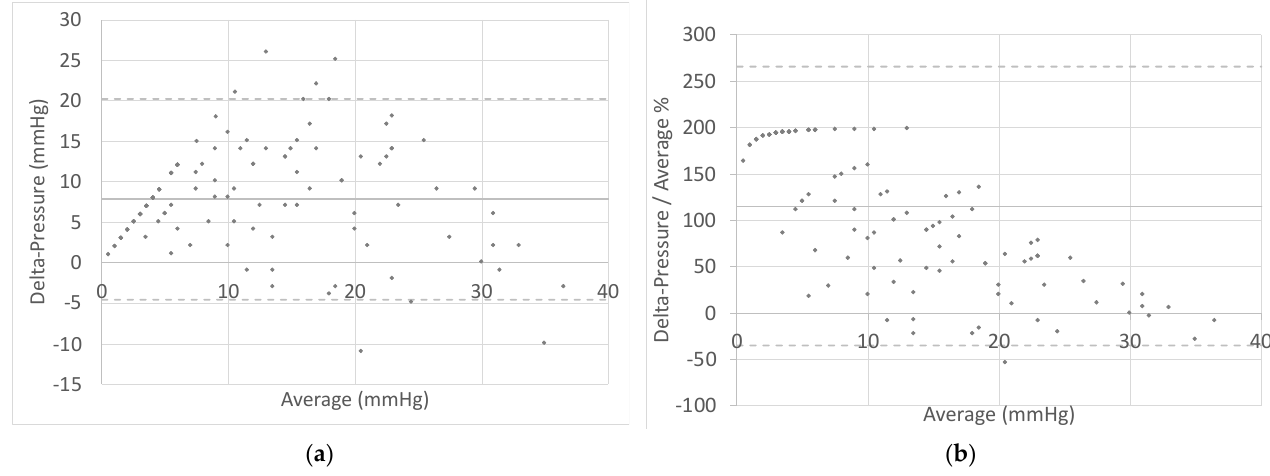
Figure 5. ( a ) Bland–Altman plot: the difference in the measurements of intraocular pressure by the two instruments (delta-pressure) as a function of the average of the two measurements (average); ( b ) Bland–Altman PI plot: Delta-pressure difference is normalized to average and given in percentage.